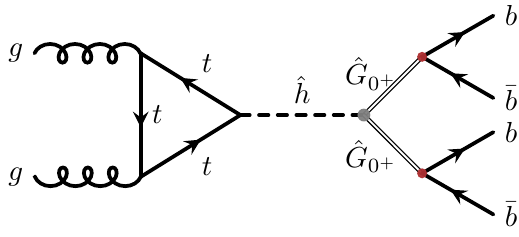
production via 0 +